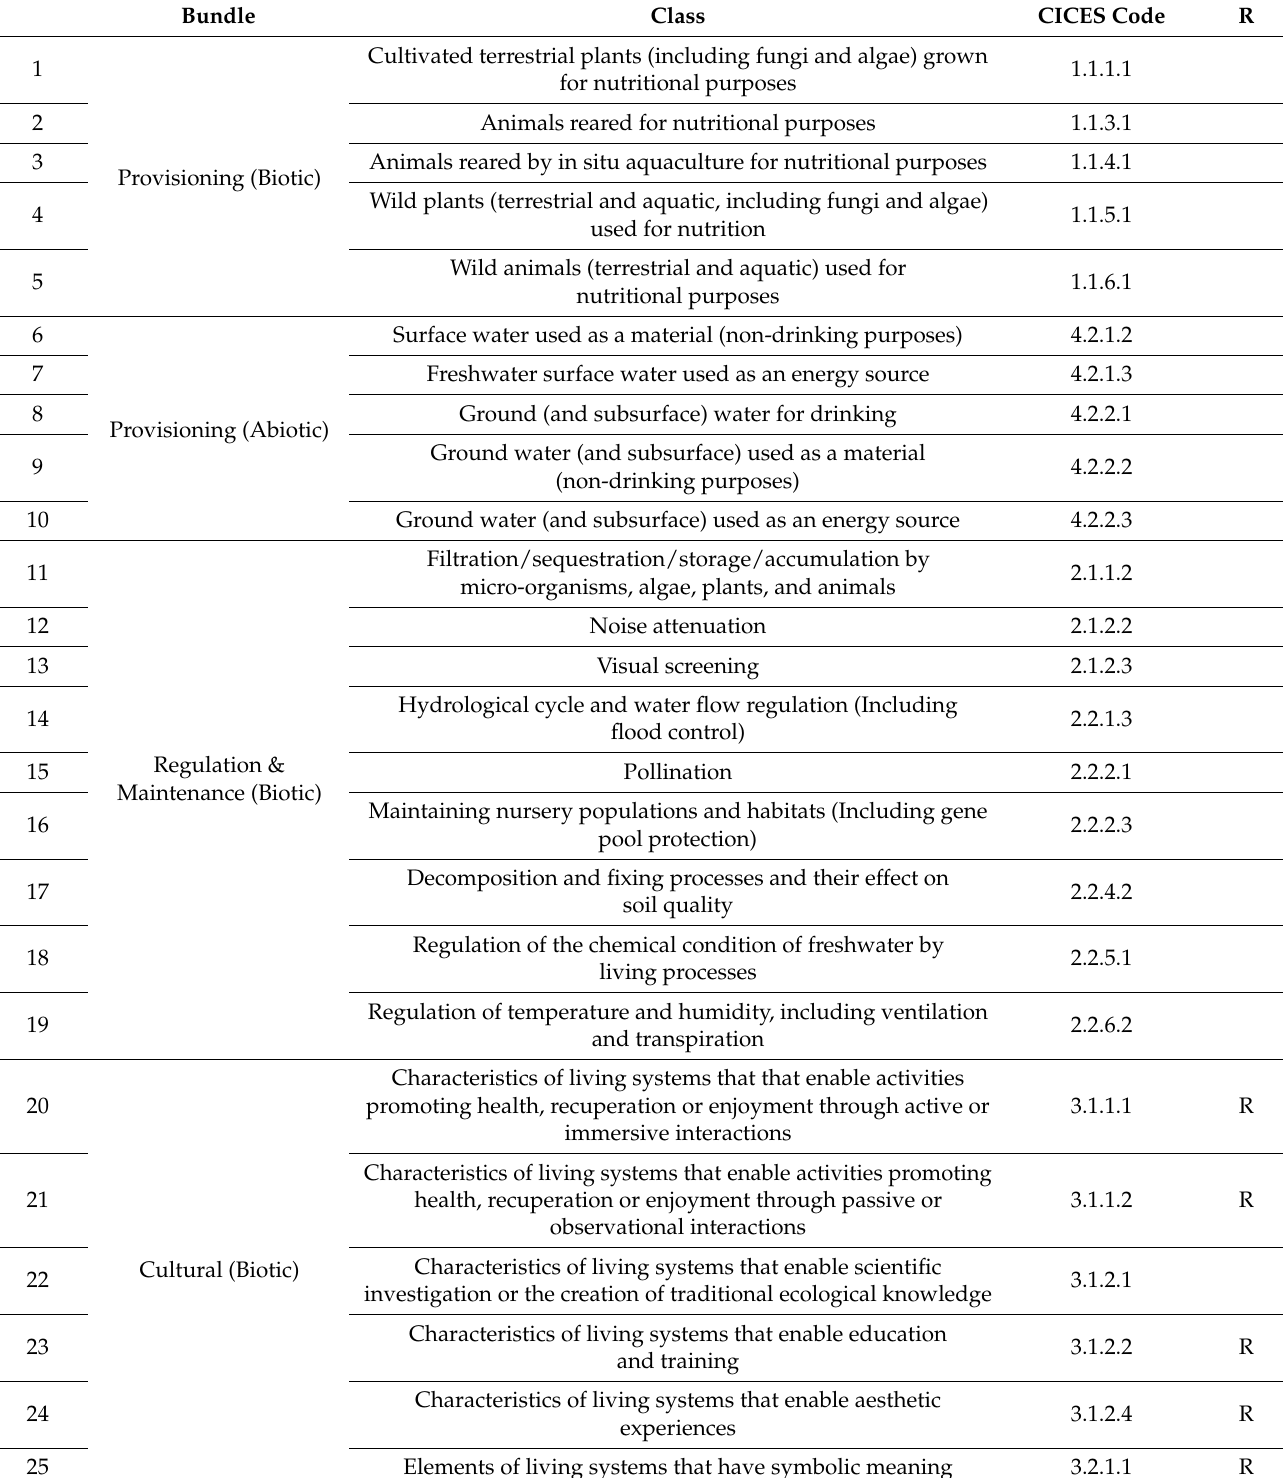
Table 2. Selected ES used in the assessment. Column R indicates the ES used to estimate the recreation